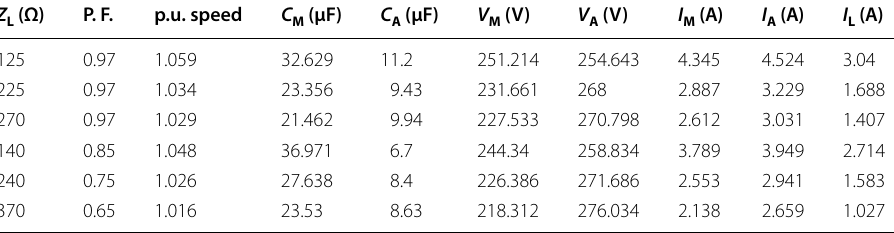
Table 3 Dynamic responses of the proposed connection of the TWSPSEIG at inductive loads Z L (Ω) P.